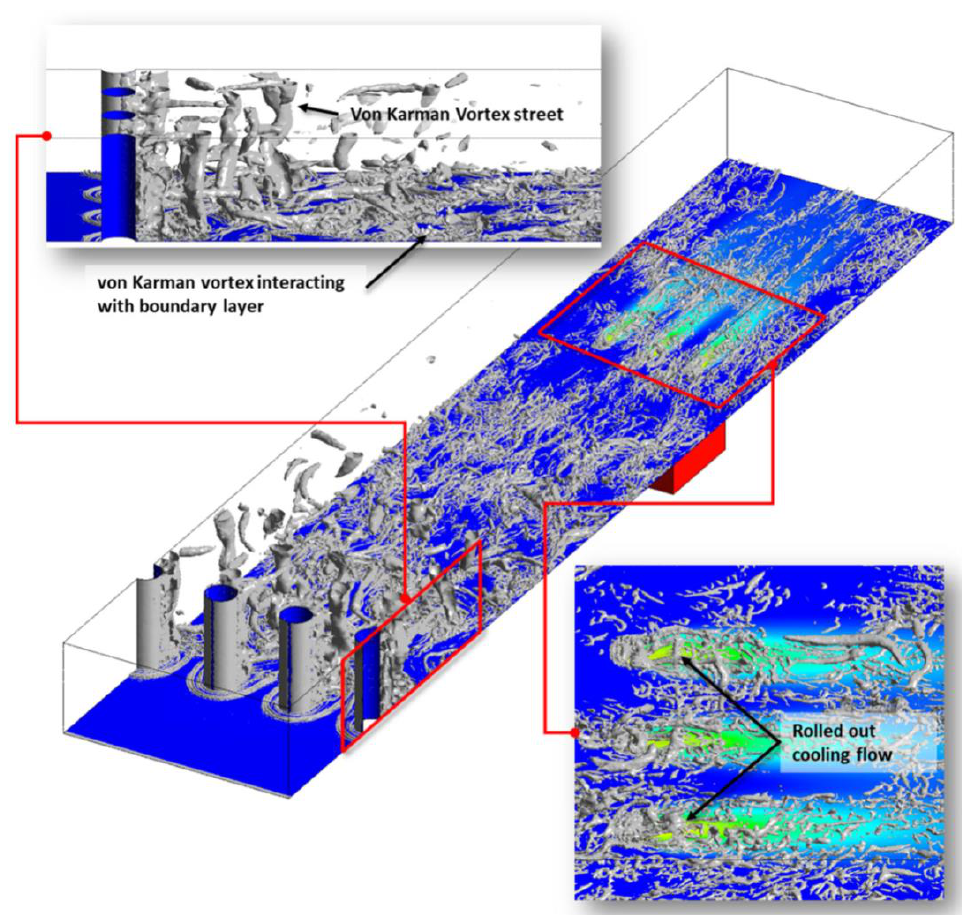
Figure 11. Vortex structures of shaped-hole film cooling supplied with free-stream turbulence created using a vertical cylinder [87].